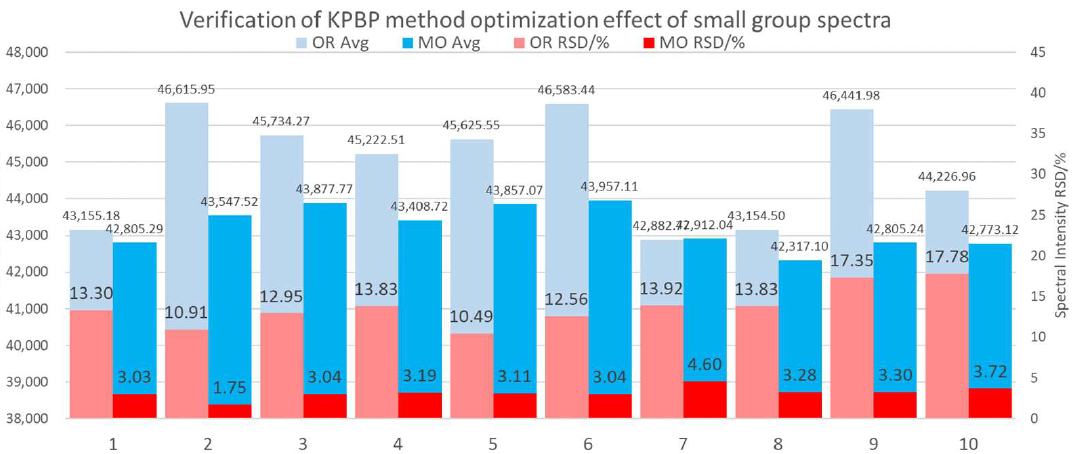
Figure 11. Evaluation of the effectiveness of the KPBP method by comparing a small spectral group’s standardization results.